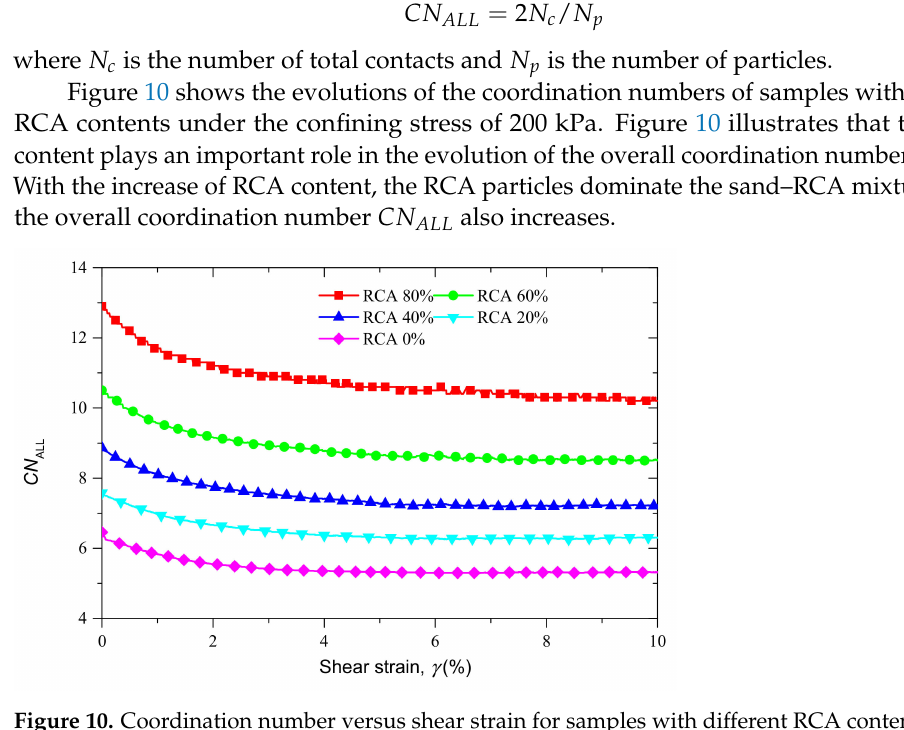
Figure 10. Coordination number versus shear strain for samples with different RCA contents under confining stress of 200